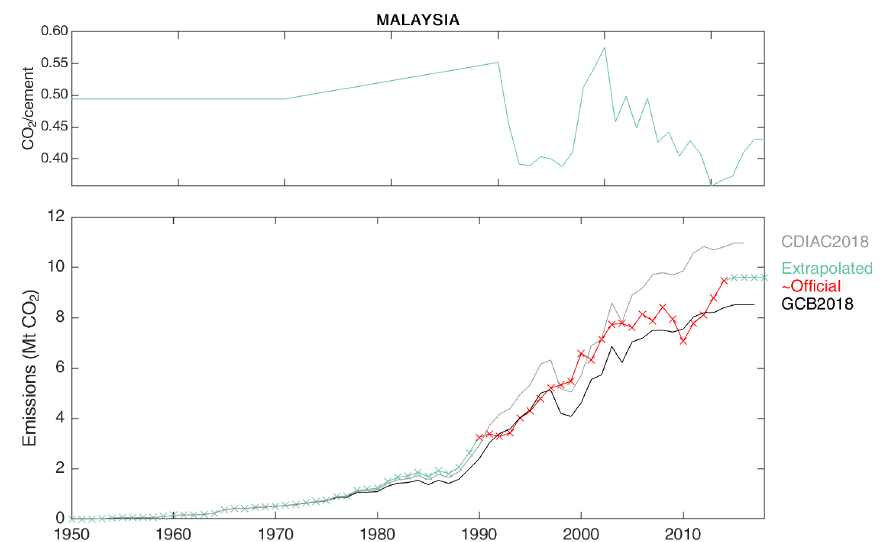
Figure C28. Revised cement emissions for